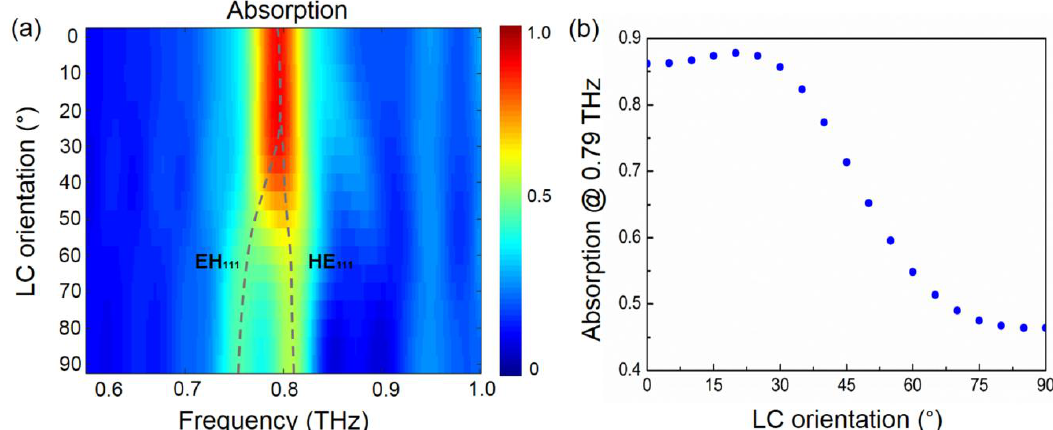
Figure 4. ( a ) Simulated absorption spectra along with the LC orientation changes from 0° to 90°. ( b ) The absorption at 0.79 THz when the LC orientation changed from 0° to 90°.